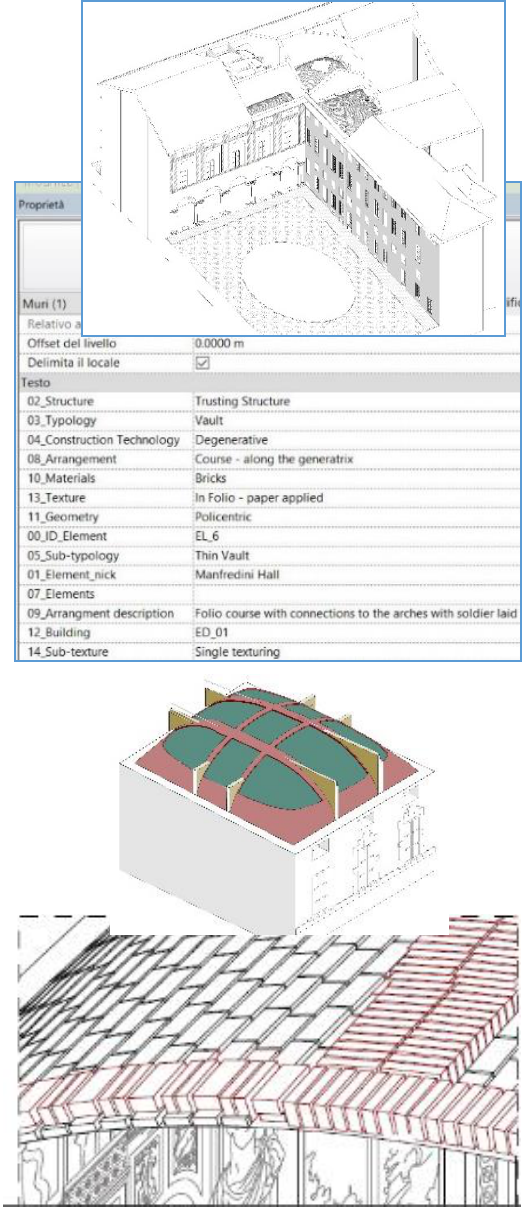
Figure 2. Palazzo Magio Grasselli, the Manfredini Hall. HBIM model and the properties populated with the